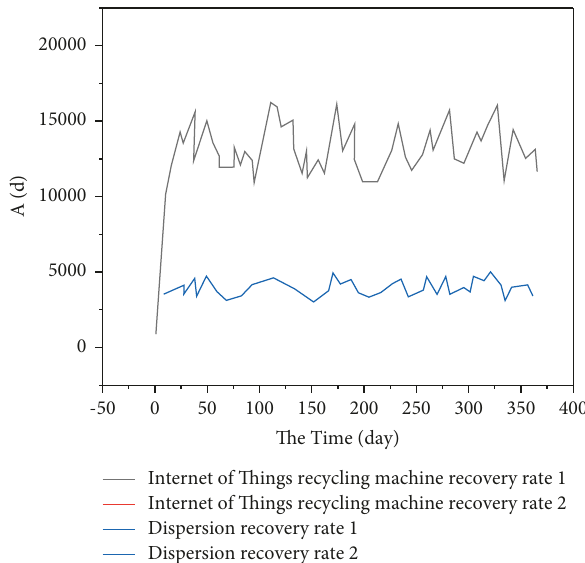
Figure 7: Influence of recovery frequency variation on the recovery rate.